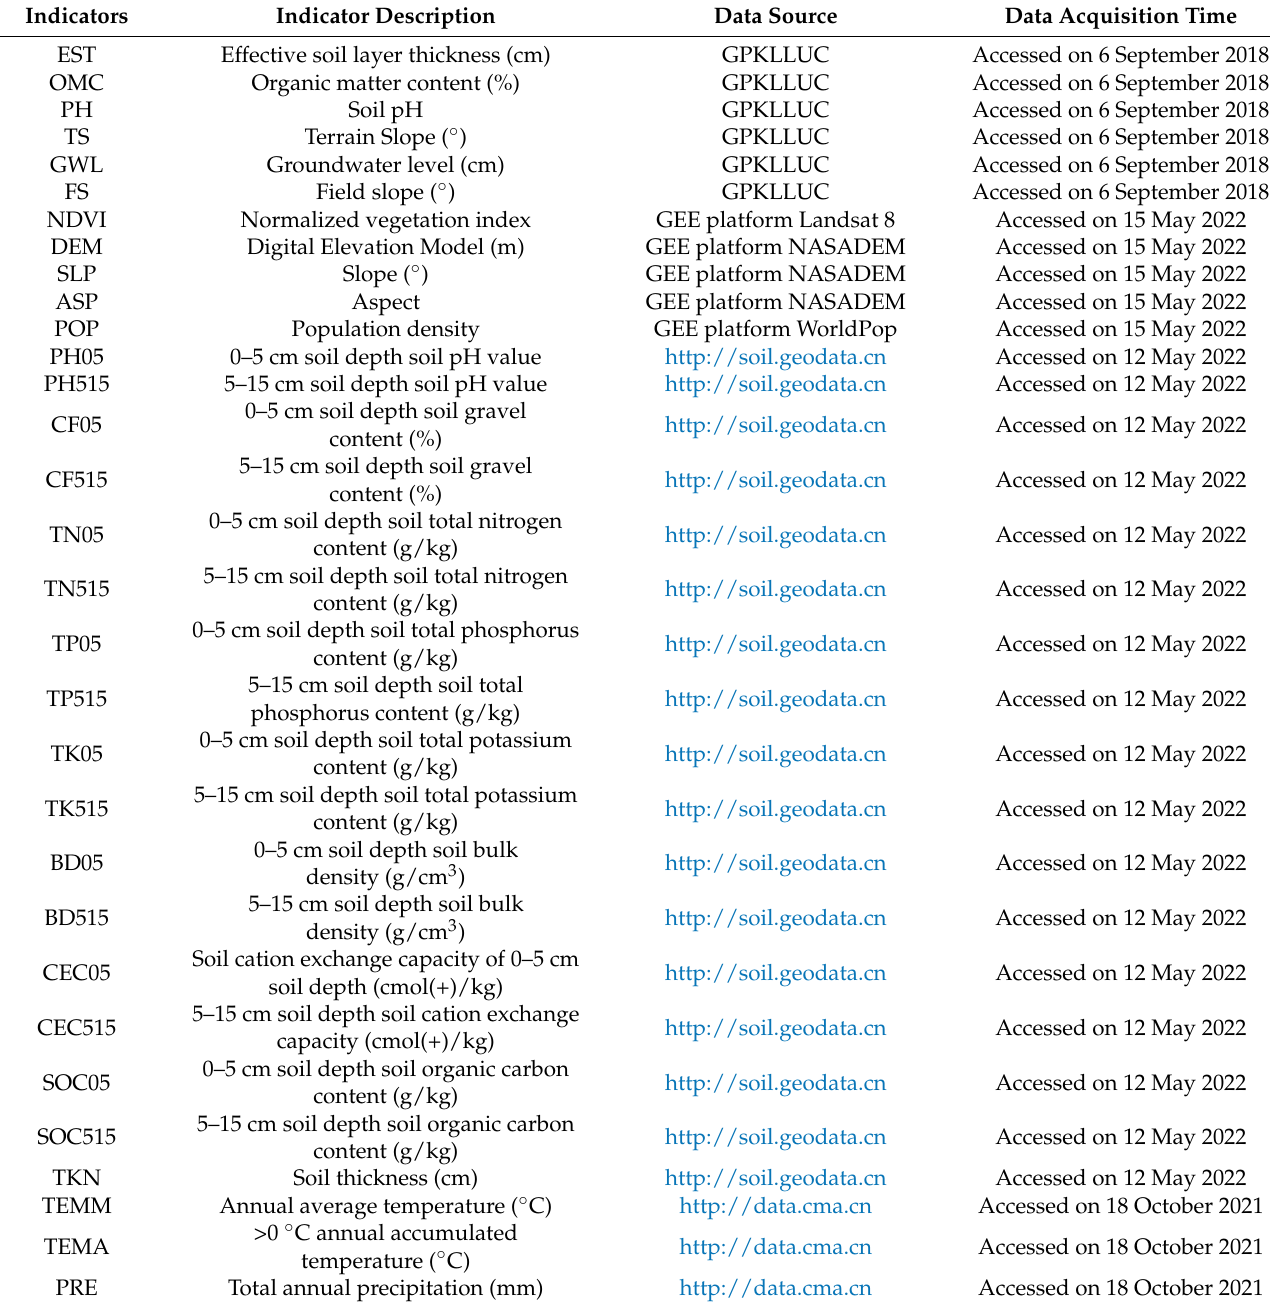
Table 1. Cultivated land quality evaluation indicator